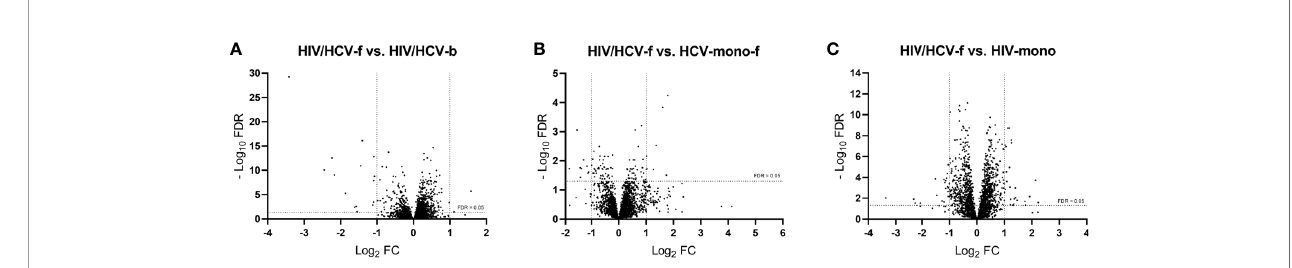
FIGURE 3 | Volcano plots showing differentially expressed genes between groups: (A) HIV/HCV-f vs. HIV/HCV-b, (B) HIV/HCV-f vs. HCV-mono-f, and (C) HIV/HCV- f vs. HIV-mono. The vertical lines represent the cut-off of FC=2, and the horizontal line indicates the cut-off of FDR=0.05. FDR, false discovery rate for multiple comparisons using Benjamini and Hochberg procedure; FC, fold-change; HIV, human immunode fi ciency virus; HCV, hepatitis C virus; HIV/HCV-f, HIV/HCV- coinfected patients 36 weeks after the sustained virological response (SVR); HCV-mono-f, HCV-monoinfected patients 36 weeks after SVR; HIV-mono,